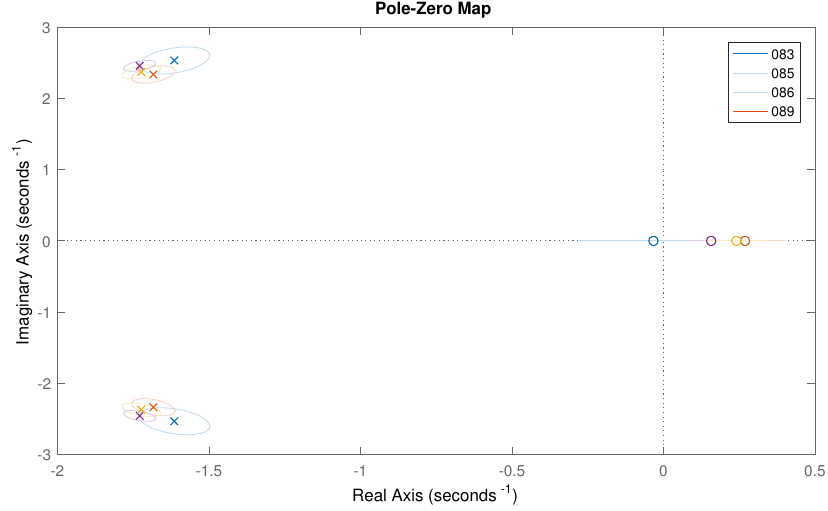
Figure 23. Pole-zero maps of the parametric models for ˆ Z r obtained from different experiments (experiments: 081, 082, 086, 087 and 089). The 95% confidence interval is shown as a circle around the poles and a line for the